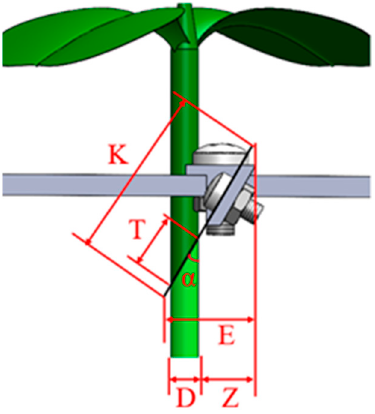
6 of 12 Figure 9. Three dimensional model of whole plate grafting machine: 1. Rack; 2. Clamping-lifting device; 3. Seedling-lowering device; 4. Synchronous-cutting device; 5. Clamping and transferring device for the upper half of the rootstock seedlings; 6. Plug tray-positioning device; 7. Upper seedling platform; 8. Scion-seedling plug tray; 9. Rootstock-seedling plug tray. The procedural steps for the full-tray grafting machine are as follows: